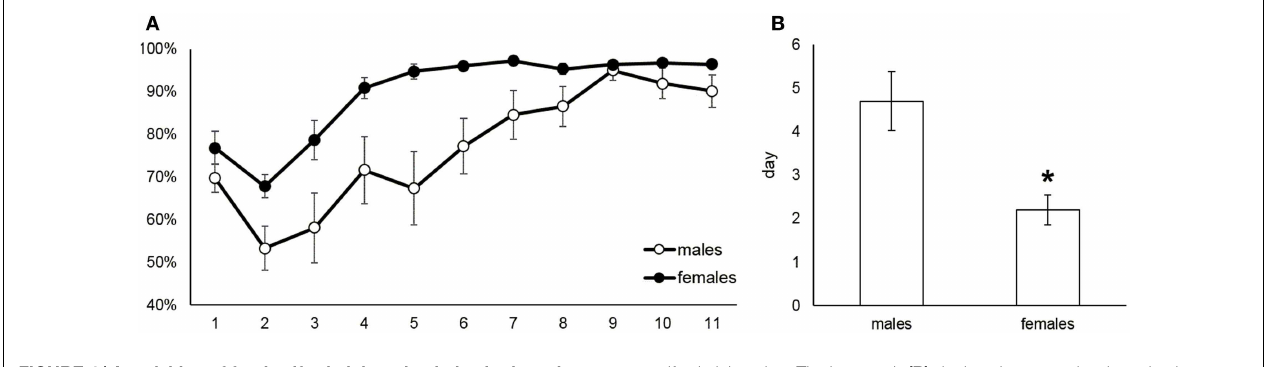
FIGURE 4 | Acquisition of food self-administration behavior in male and female rats . The (A) part shows the course of the active nose poke preference development during acquisition and maintenance of the food